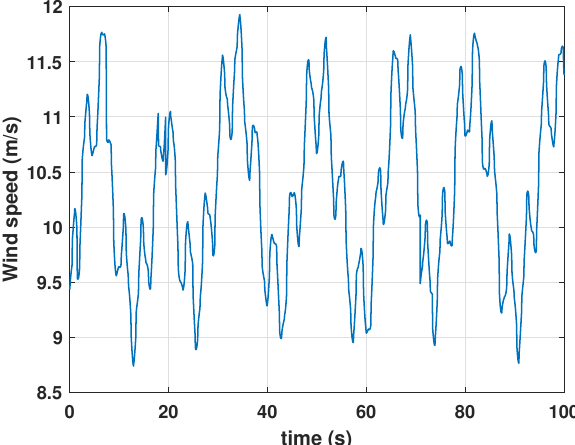
Figure 11. Wind speed variation.